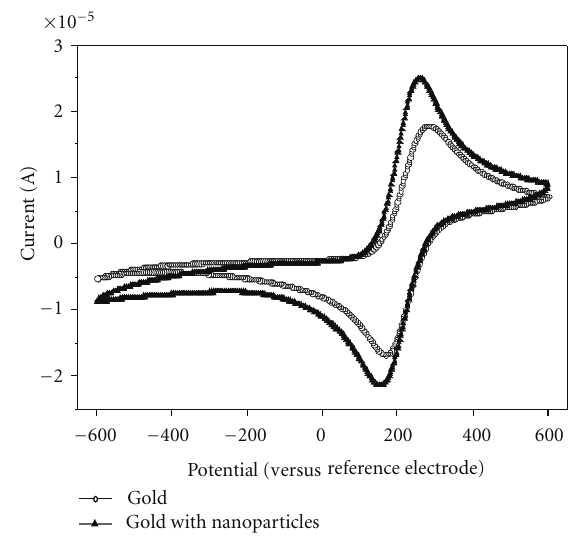
Figure 1: Cyclic voltammograms of (a) bare gold electrode; (b) bare gold electrode/magnetic beads. In presence of a 5mM redox, probe K 3 [Fe(CN) 6 ]/K 4 [Fe(CN) 6 ] versus